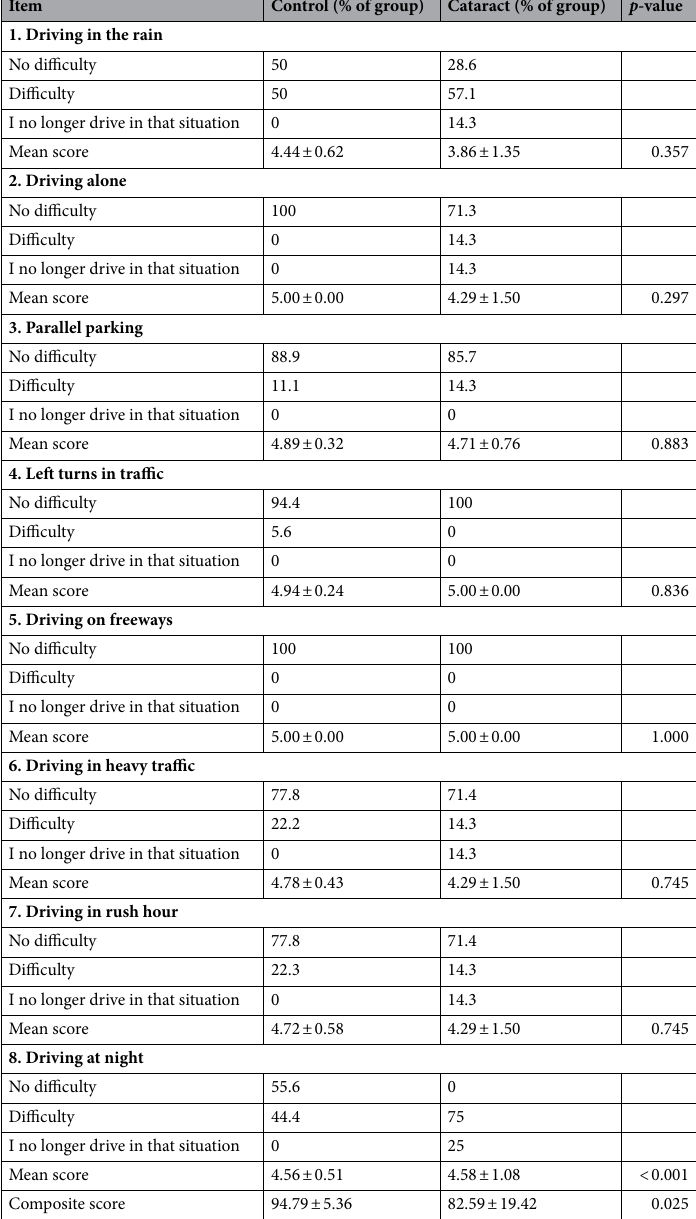
Table 6. Driving Habits Questionnaire (DHQ), comparison between drivers with and without cataract. Percentages of responses (subjects referring any level of difficulty, i.e., little, moderate, or extreme difficulty, are pooled) and mean scores are included for each item. Point scale for mean scores: 5 = no difficulty; 4 = a little difficulty; 3 = moderate difficulty; 2 = extreme difficulty; 1 = so difficult that I no longer drive in that